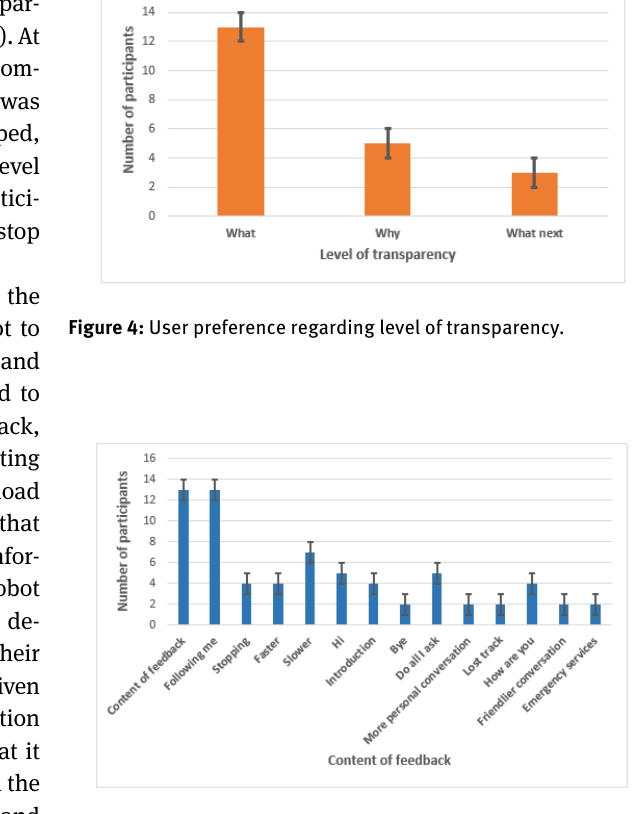
Figure 5: Users’ suggestions for content of